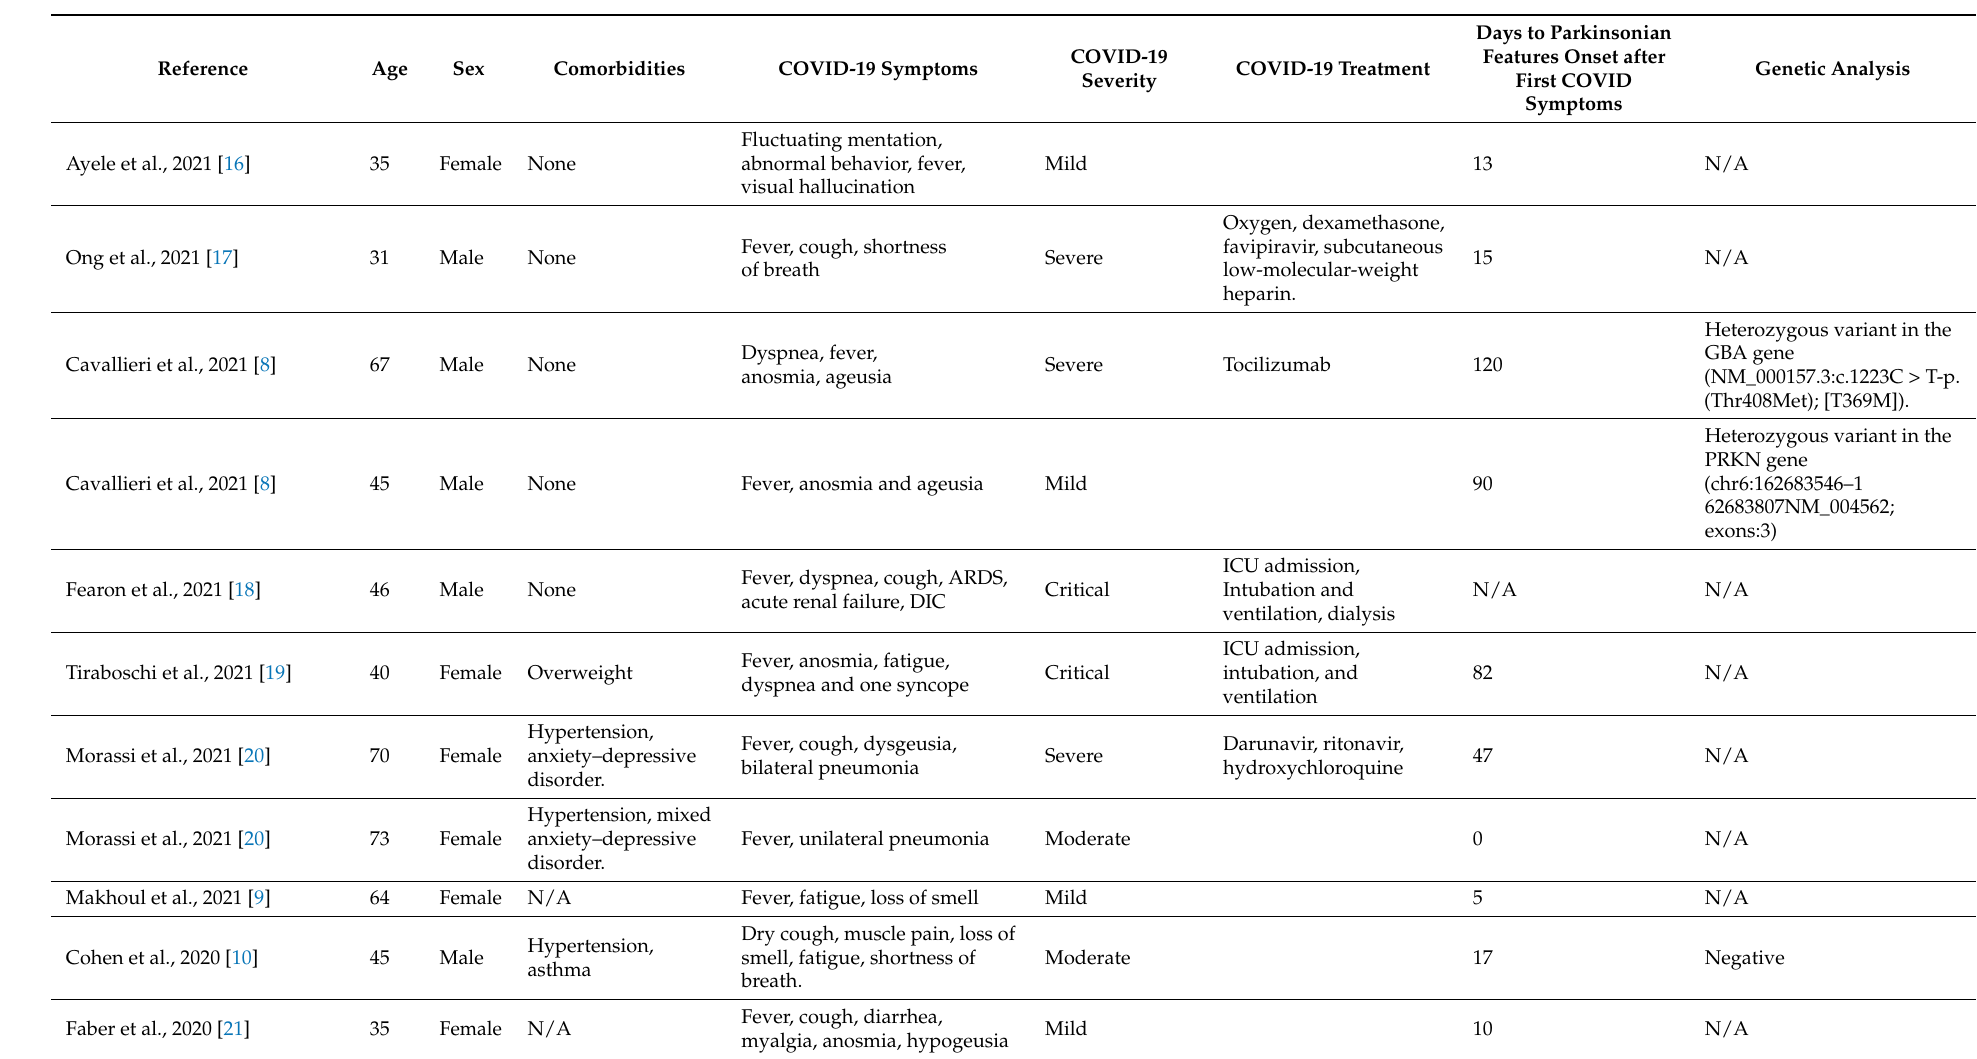
Table 1. Clinical context of the 13 patients included in the